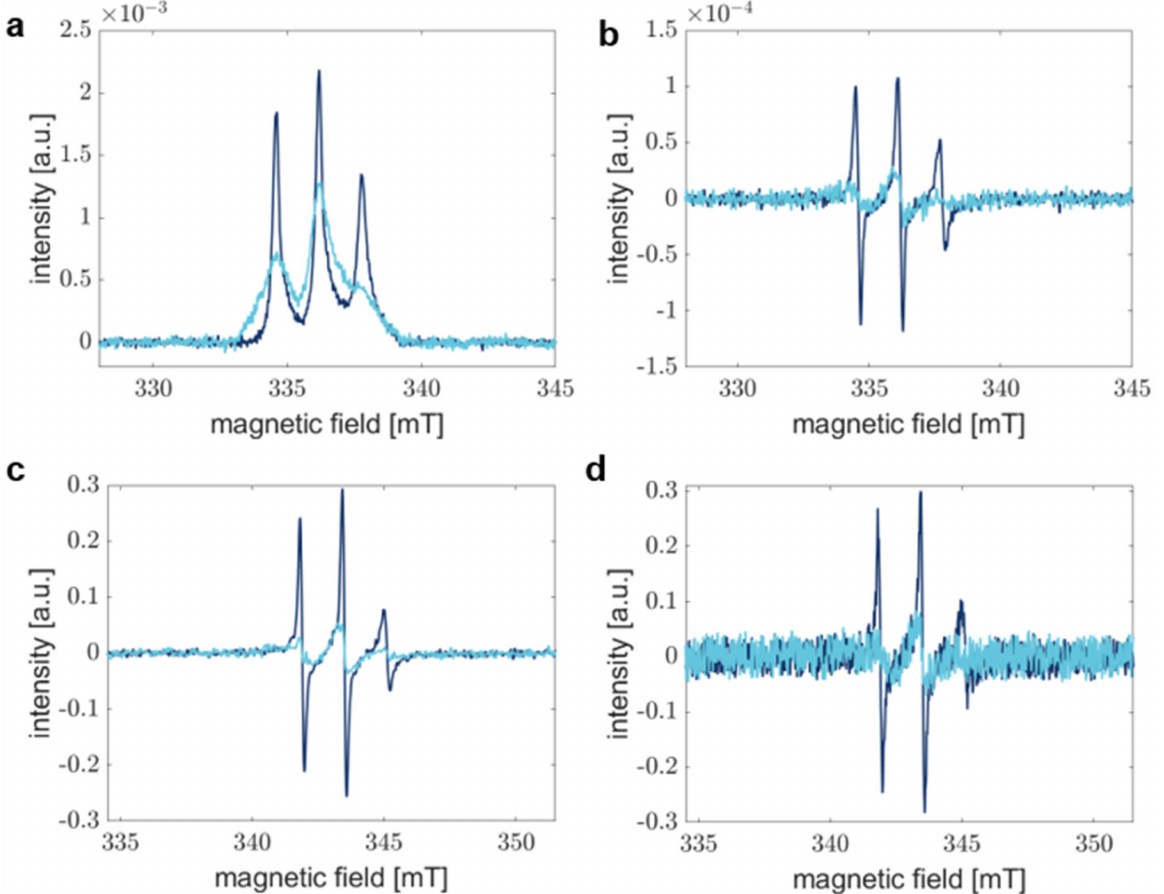
Figure 2. Comparison of the sensitivity of RS and CW EPR experiments. Dark blue spectra correspond to aS A27C-MTSSL monomer sample, whereas light blue spectra show aS in fibrils. ( a ) Absorption spectra recorded by RS EPR spectroscopy were accumulated for 1 min. ( b ) Pseudo-modulated RS EPR spectra from ( a ) modulated with 0.1 mT. ( c ) CW EPR spectra after 30 min of acquisition and averaging. ( d ) CW EPR spectra represent accumulation for 1 min. Field modulation in CW ( c , d ) results in the detection of the first derivative of the absorption